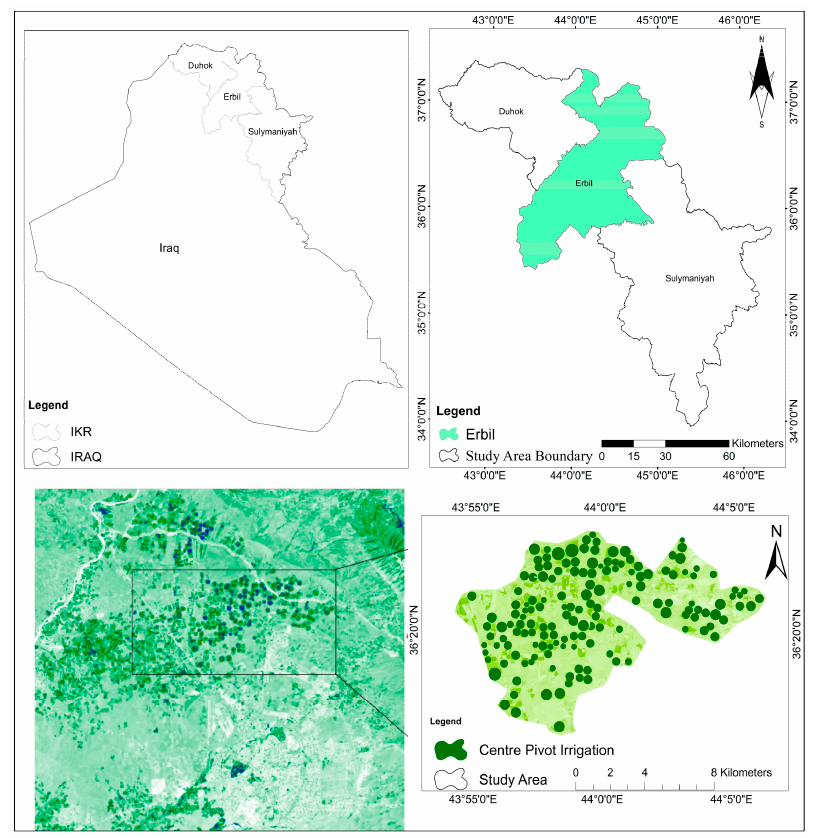
Figure 1. Site map of the study area in Erbil,